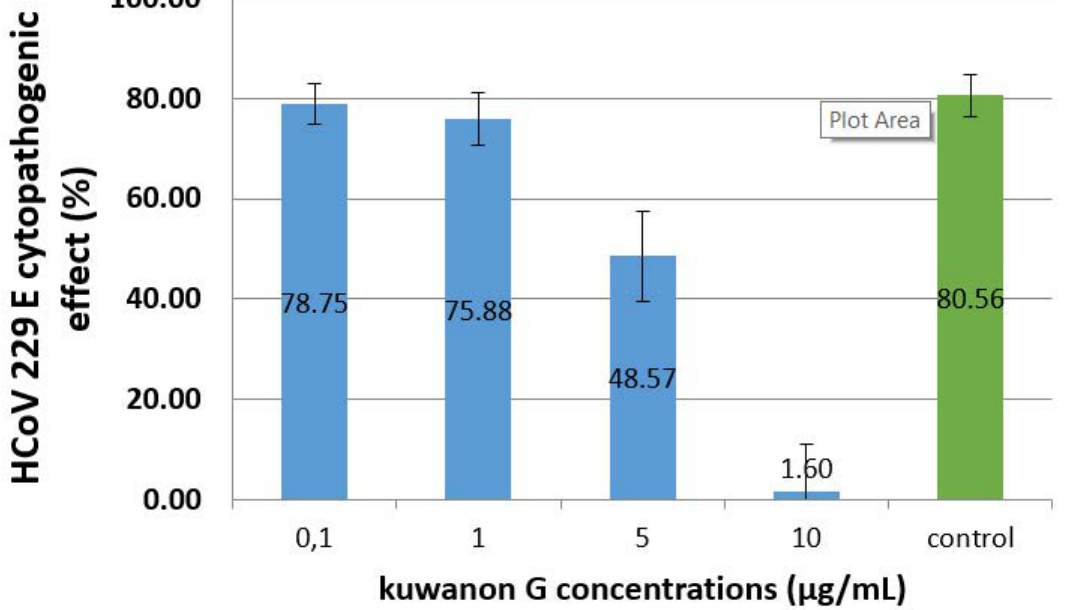
Figure 3. Evaluation of HCoV 229E cytopathogenic e ff ects on L-132 cells (MOI = 1) in the presence of kuwanon G at di ff erent concentrations between 0.1 and 10 µ g / mL at 72 h post-infection. However, a concentration of 10 µ g / mL strongly reduced the CPE down to